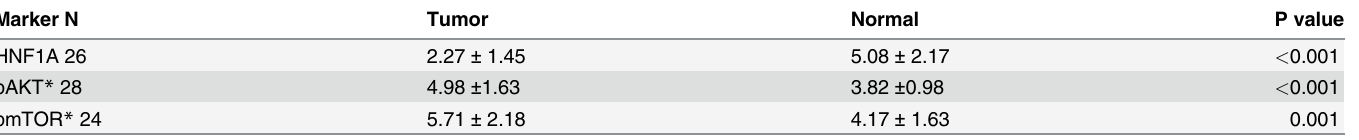
Table 1. Expression of HNF1A, pAKT, pmTOR in paired tumor and normal pancreatic tissues. Marker N